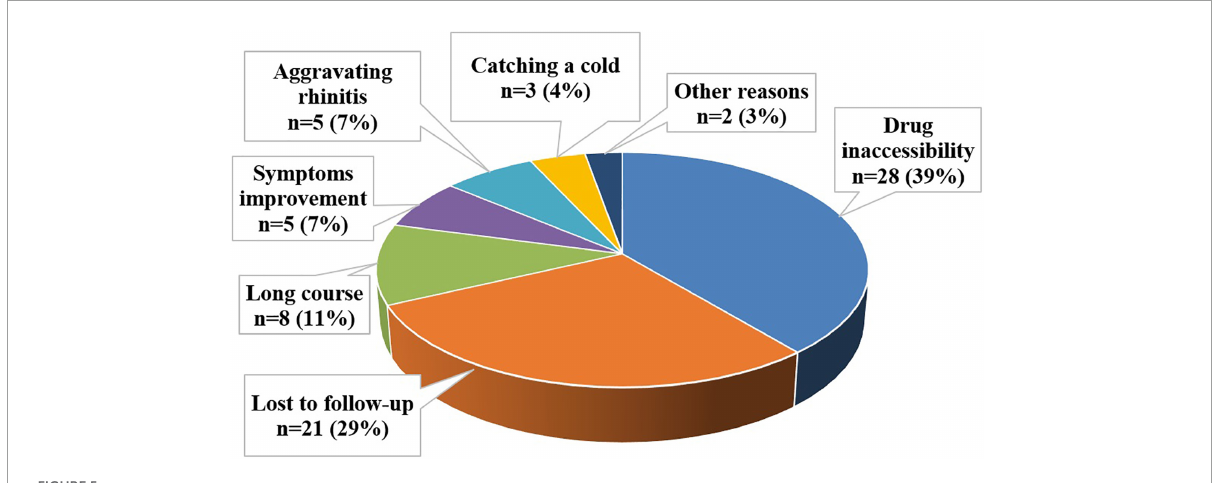
FIGURE5 Reasons for discontinuation of